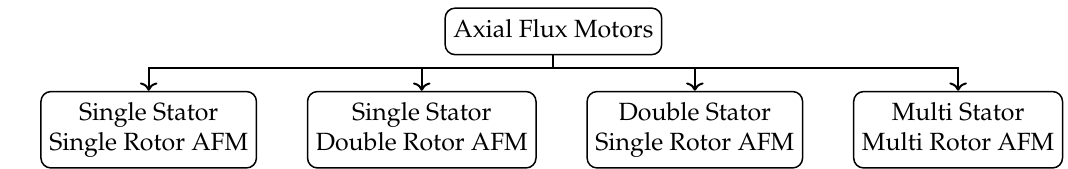
Figure 9. Axial Flux Motors